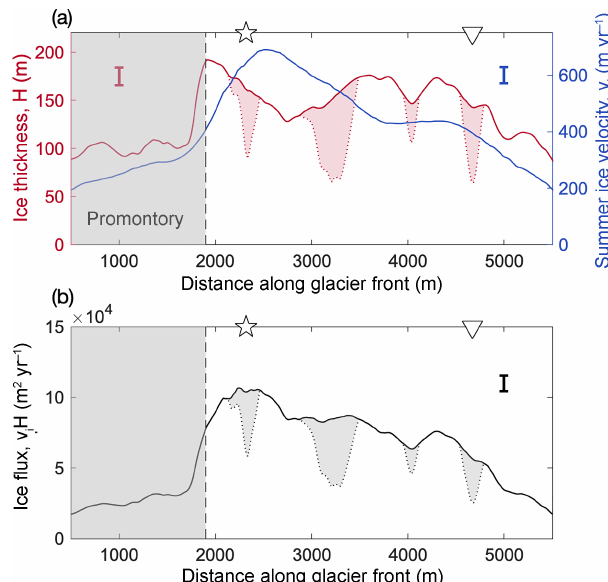
Figure 3. (a) Mean July ice velocity along the glacier front in blue (right vertical axis). Here we used cubic interpolation to fill the data gap shown in Fig. 2b. In red (left vertical axis) is shown the esti- mated ice thickness along the glacier front, obtained by computing the difference of the surface and bathymetry profiles of Fig. 1c. The red dotted line shows the ice thickness at the glacier front assuming the ice is locally in isostatic equilibrium everywhere. (b) Ice flux per unit width along the glacier front (in black), computed from the product of velocity and thickness (shown in a ). The shaded gray areas under the curve show the ice-flux range due to poten- tial flotation. This is a result of the thickness ranges indicated as red shaded areas in (a) . Uncertainties for thickness, velocity, and ice flux are shown by the red, blue, and black standard error bars, re- spectively. Also indicated are the approximate locations of the two known plumes ( , (cid:79) ), which coincide with two areas of possible